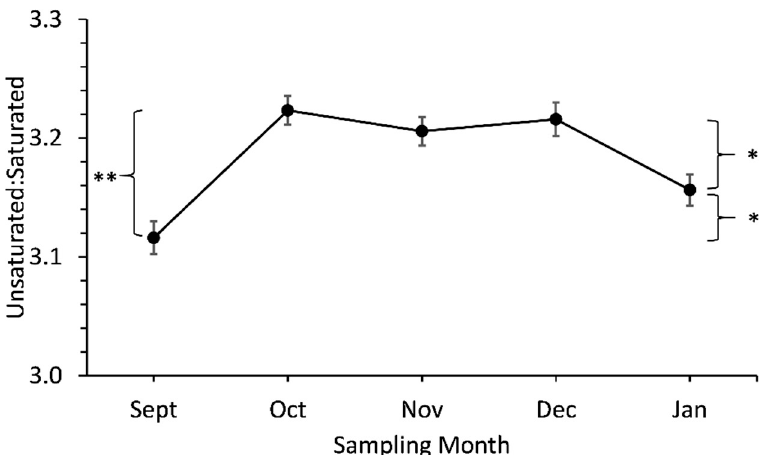
Figure 3. Unsaturated: saturated FA ratio of balsam fir branches based on sampling date. Data points represent mean ± standard error as calculated from 20 branches. The * represents 1% to 5% significance and ** represents less than 1% significance. Table 1. Fatty acid relative percentages in balsam fir needles from low and high needle abscission resistance genotypes of balsam fir collected initially in September to establish a baseline fatty acid profile at the beginning of the experiment. Relative percentages are displayed as mean ± standard error as calculated from 20 branches. An * indicates 1–5% significance while ** indicates less than 1%